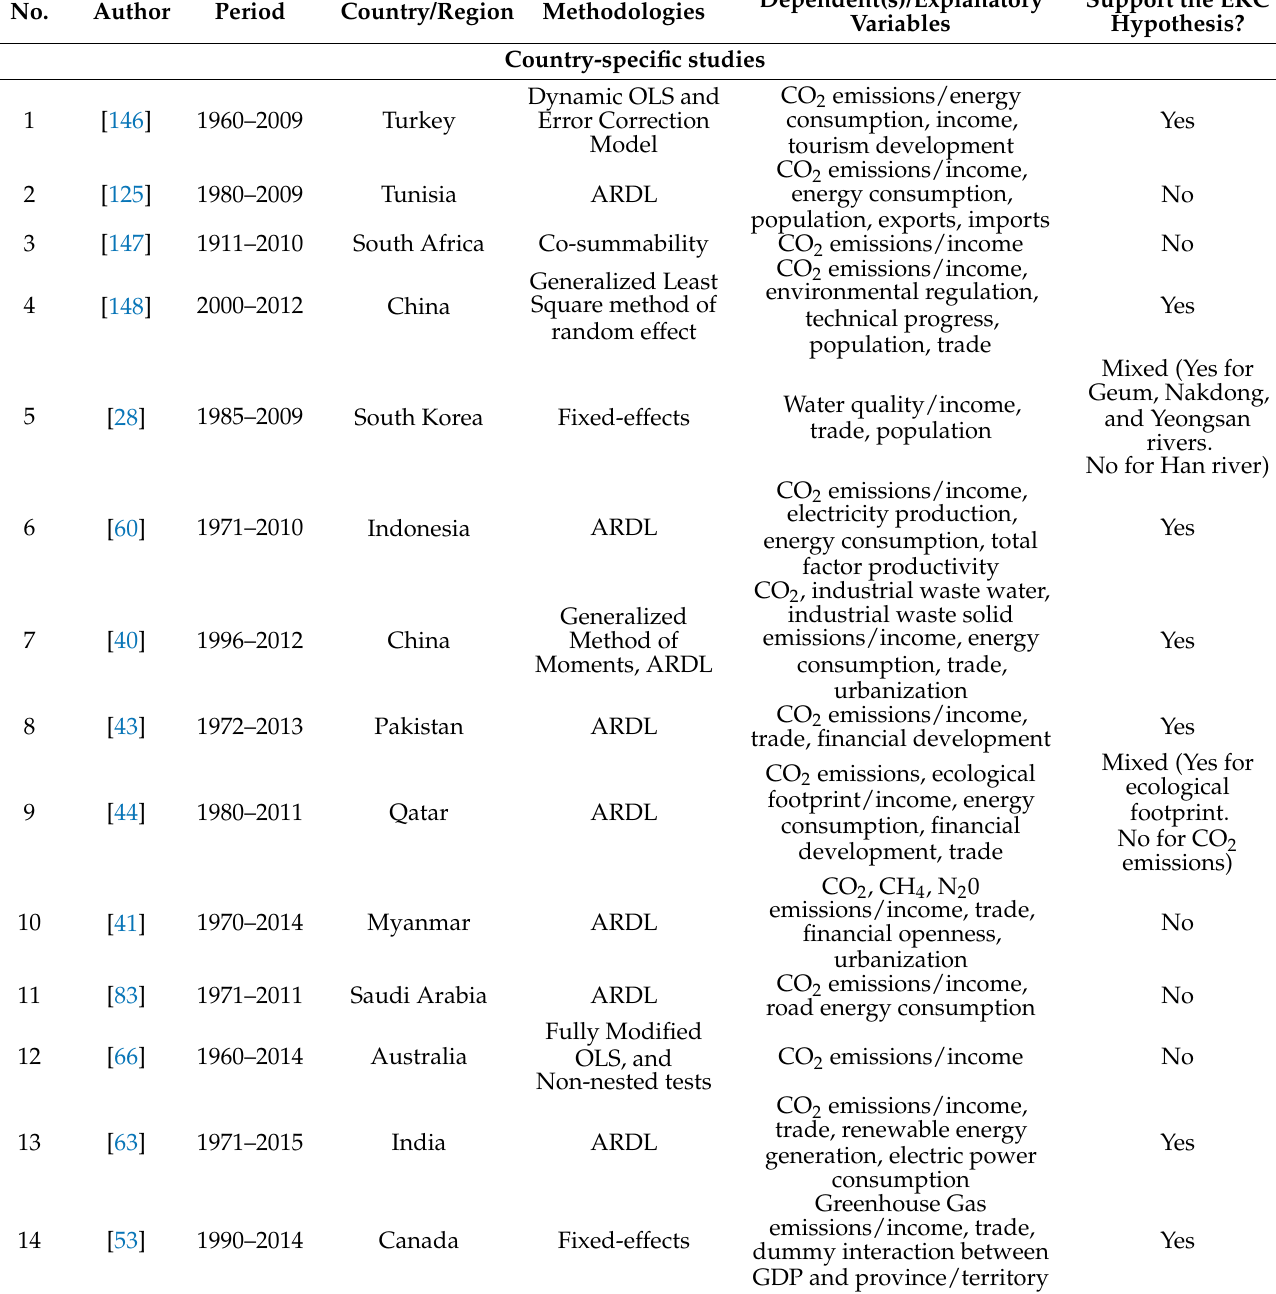
Table A1. Summary of previous empirical studies on the EKC